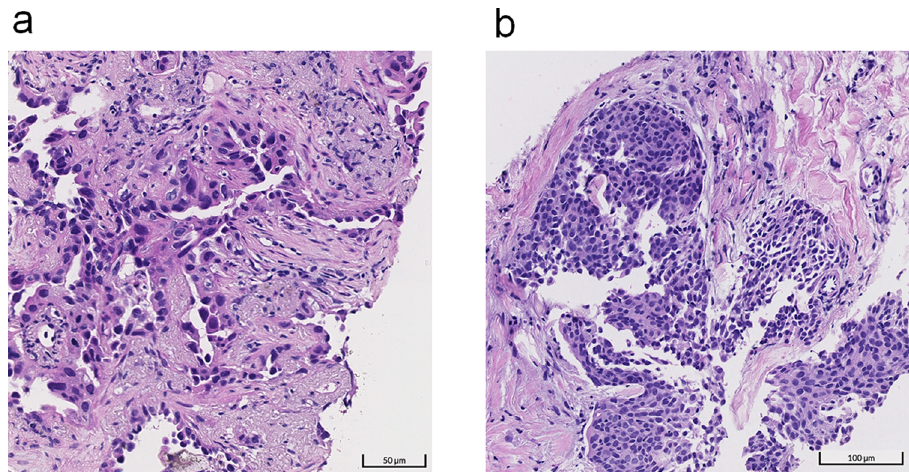
Fig. 1 Examples of pathological images of major lung cancers. Pathological images of adenocarcinoma and squamous cell carcinoma are displayed in a and b ,